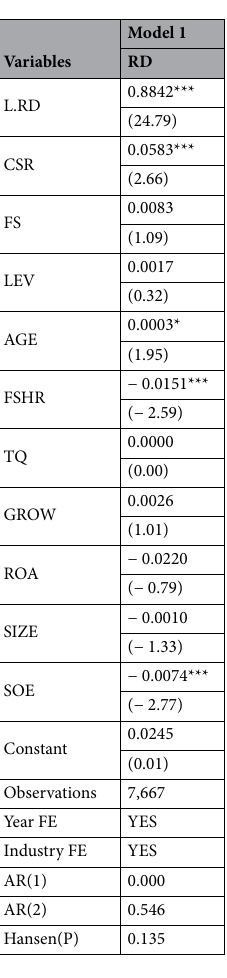
Table 9. The two-step systematic GMM method. ***, ** and * respectively indicate that the parameter estimation is significant at the levels of 0.01, 0.05 and 0.1. The “t” value is in parentheses. AR(1), AR(2), and Hansen(P) are the p -values corresponding to the test